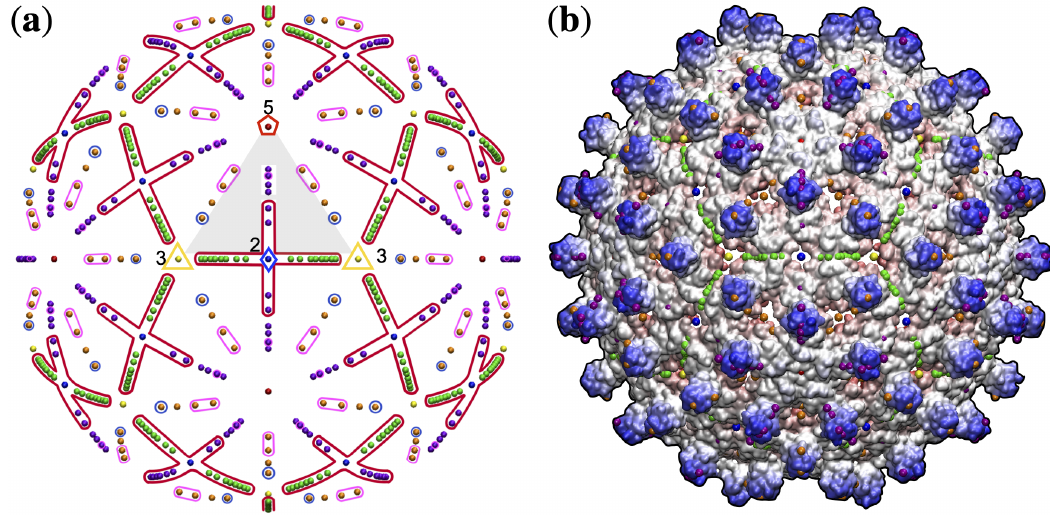
Figure 3. ( a ) The gauge points of the point arrays [2–5] are found on the icosahedral great circles which subtend neighboring symmetry axes, and define the Asymmetric Unit (AU), shown in grey. The AU is a 1/60th representative section of the full icosahedral capsid and there are 21 unique gauge points within it. These points are all colored based on where they are relative to the symmetry axes and the great circles they connect; 5-folds are red, 3-folds are yellow, 2-folds are blue, then purple is between 5 (red) and 2 (blue), green is between 2 (blue) and 3 (yellow), orange is between 5 (red) and 3 (yellow), finally black points are not on great circles, instead they are found anywhere else and are referred to as bulk points. The angular locations of these points are shown to scale. By analyzing the structural protrusions and the genomic composition of viruses, we found that only RNA viruses are found to use the encircled red region ( ⊥ ), and also dominate areas encircled with pink. Finally, only ssDNA viruses use the encircled blue region (near 3-fold axes). ( b ) The gauge points arranged atop HBV (T4, 1qgt) virus. There are two potential structural protrusions within the AU, located along the 5–2 arc (purple) and the 3–5 arc (orange). We find that only the point arrays corresponding to purple protrusion GP 19 have corresponding arrays which meet the criteria for a proper fit [3], so there is only one structural protrusion in